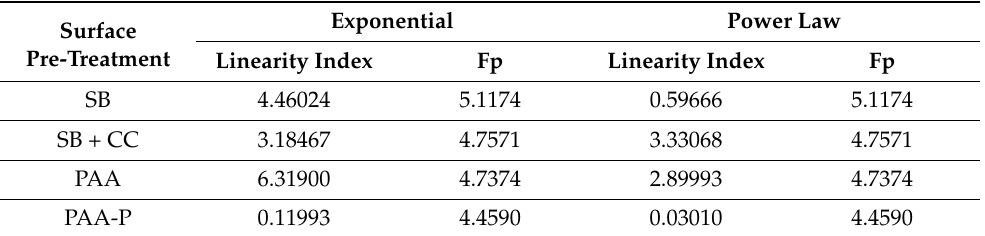
Table A2. Calculation of the linearity index for the exponential and power-law models.